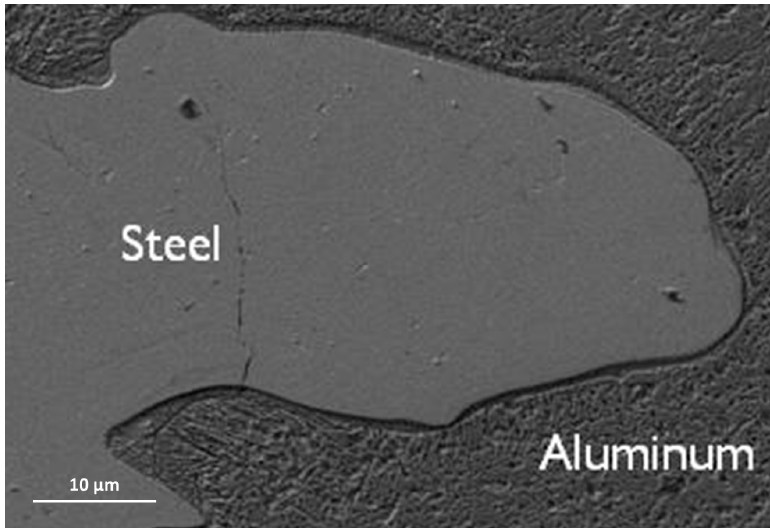
Figure 18. SEM picture showing the highly irregular and non-homogeneous Steel/Al interface.